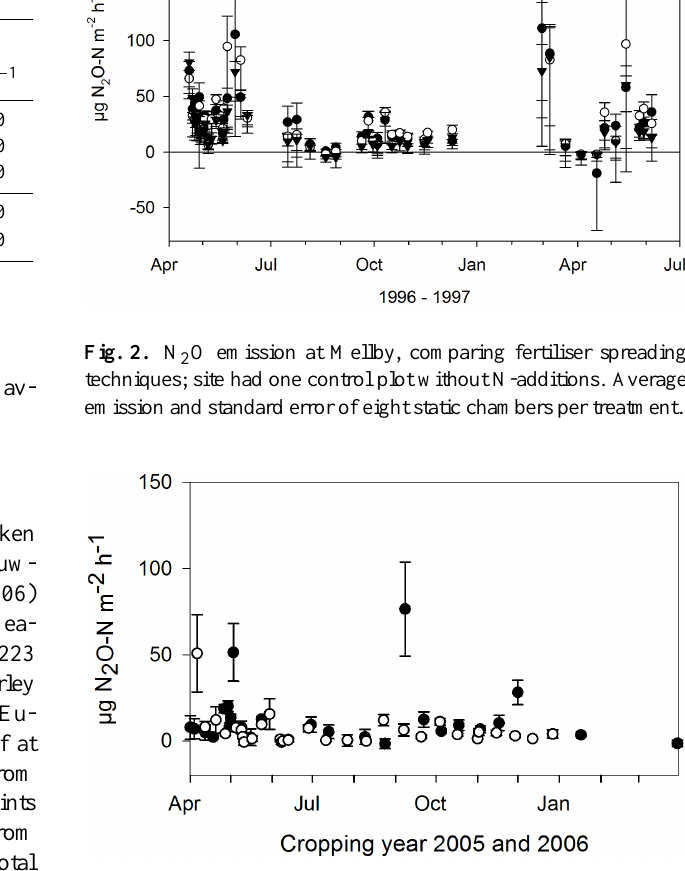
Fig. 3. N 2 O emission at Log˚arden, for two different plots with spring wheat in a 7-yr crop rotation (C6 in 2005 ( • ) and C2 in 2006 ( ◦ )); average and standard error of six